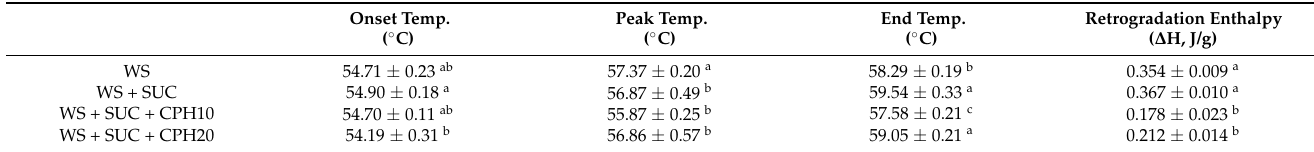
Table 3. Thermal properties of the wheat starch gel added with sucrose and citrus peel hydrolysates stored for 5 days. Onset Temp. ( ◦